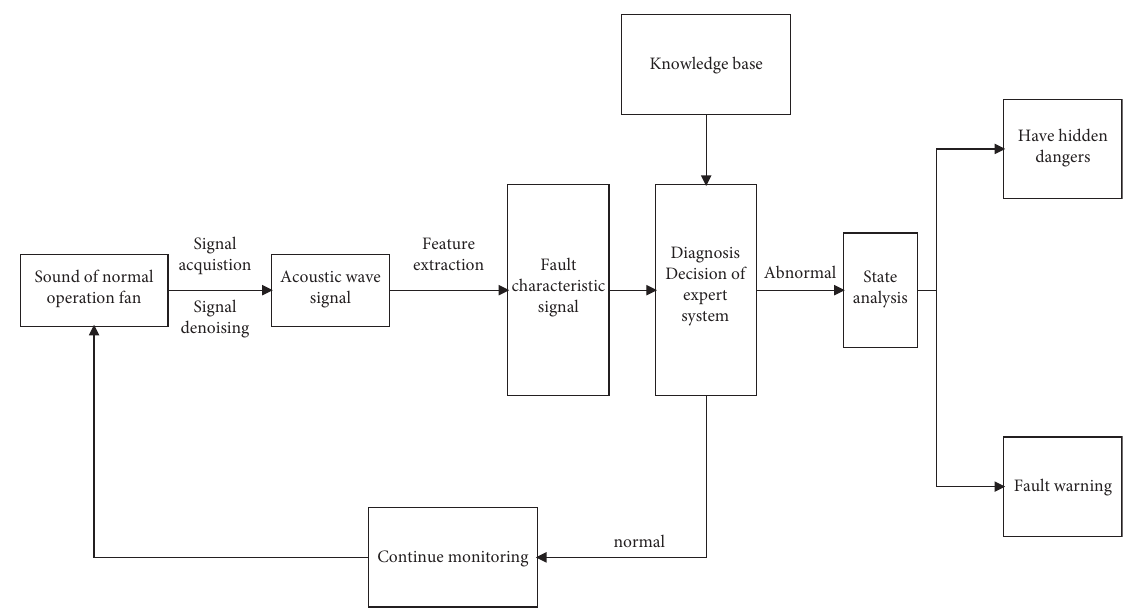
Figure 1: Fault diagnosis system diagram of mine